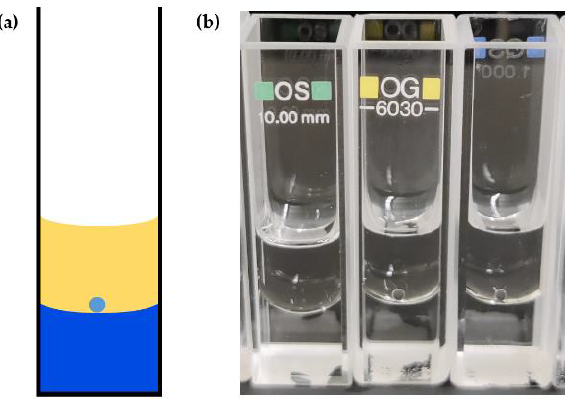
Figure 1. Measurement setup for the coalescence time measurement. ( a ) Sketch of the phases. The continuous water phase W2 (dark blue) with hydrophilic surfactant and the oil phase (yellow) with lipophilic surfactant. The W1 droplet (light blue) is without surfactant. ( b ) Photography of three measurement cuvettes. The droplet on the left is already coalesced, while the middle and the right droplet are still at the